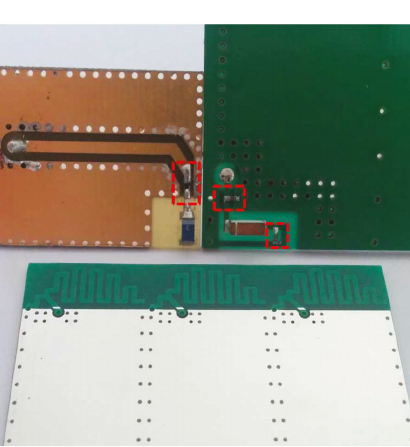
Figure 8: Compared result to Walsin (left) and Murata (right)